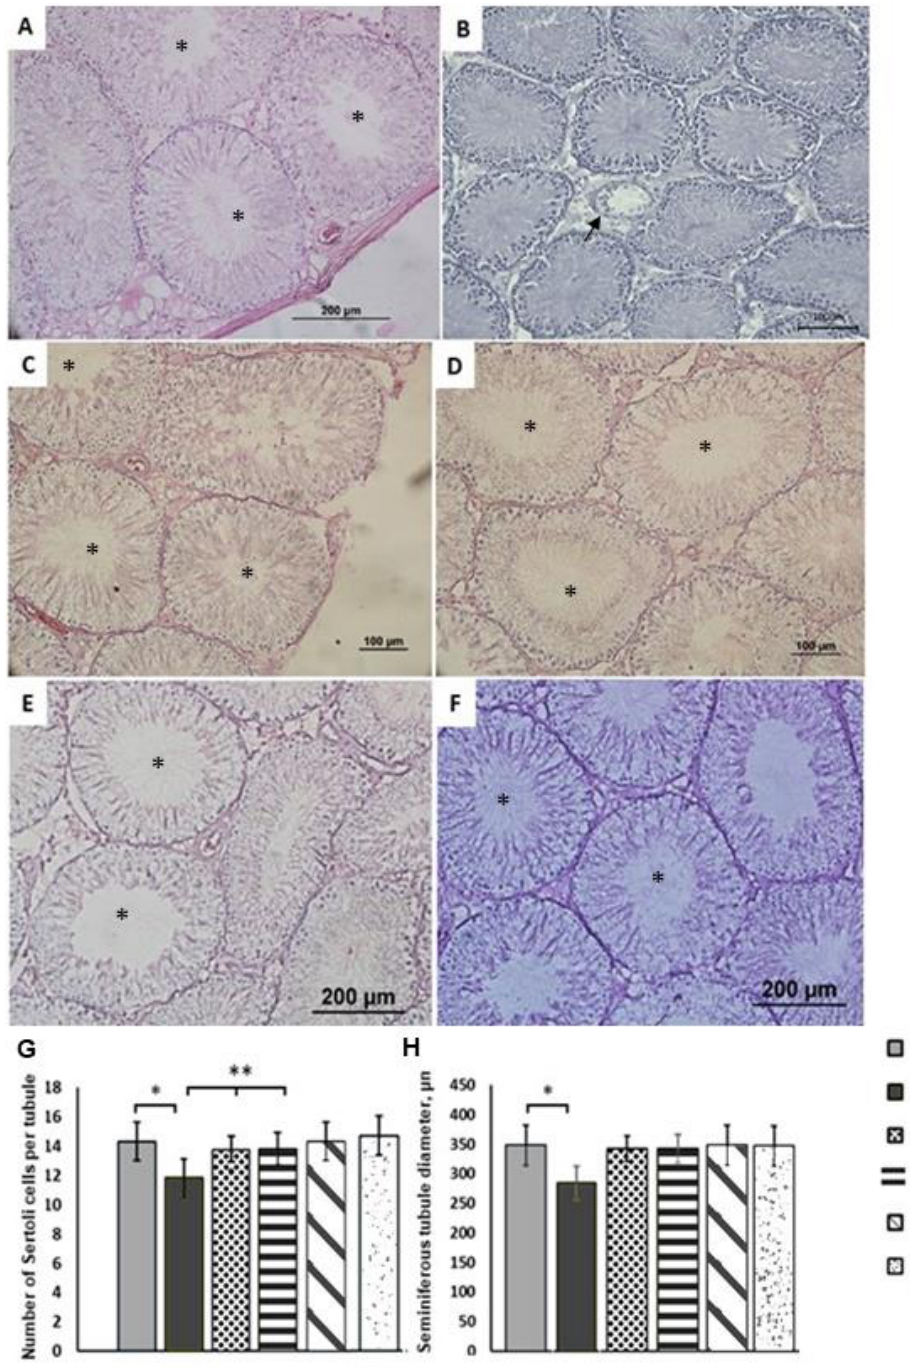
Figure 5. The morphology of testicular tissue on PND 80 exposed on ED12 to ( A ) 0.9% NaCl (control); ( B ) lipopolysaccharide (LPS, 50 μg/kg); ( C ) LPS and IgG; ( D ) LPS and IL-6RmAbs; ( E ) 0.9% NaCl and IgG; and ( F ) 0.9% NaCl and IL-6RmAbs. Hematoxylin/eosin staining. Scale bar = 100 μm. *—lumen, arrow—degrading tubule. ( G ) The number of Sertoli cells per seminiferous tubule (mean ± SEM) and ( H ) seminiferous tubule diameters in male rats on PND80 after exposure on ED12 to 0.9% NaCl (control); LPS; LPS and IgG; LPS and IL-6RmAbs; 0.9% NaCl and IgG; and 0.9% NaCl and IL-6RmAbs. M ± SEM. * p < 0.05, compared with the control group, ** p < 0.05, compared with the LPS-exposed group. A total of 50 randomly chosen round tubules from each animal were measured; Sertoli cells were counted in 30 round tubules from each animal; n = 10 animals per